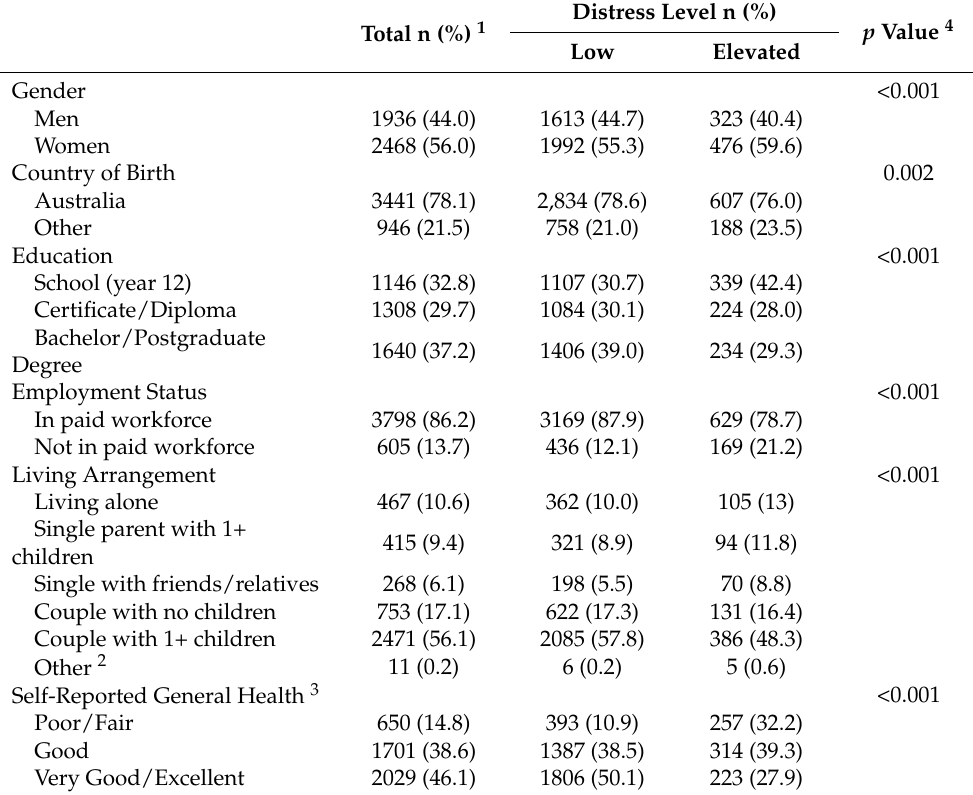
Figure 3. Psychological distress scores over time in low and elevated distress trajectory groups. ◦ Table 2. Summary characteristics of analytic sample of mid aged adults at baseline (n = 4404).